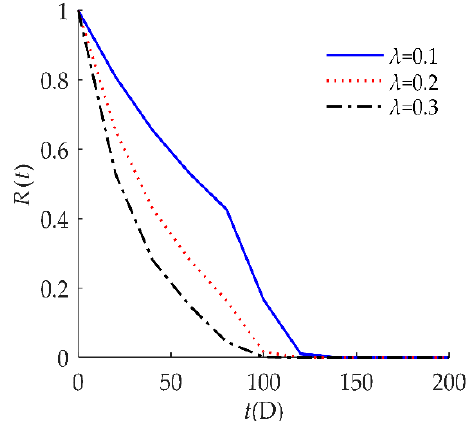
Figure 12. Sensitivity analysis of R ( t ) on H for example II. Sensors 2018 , 18 , x FOR PEER REVIEW